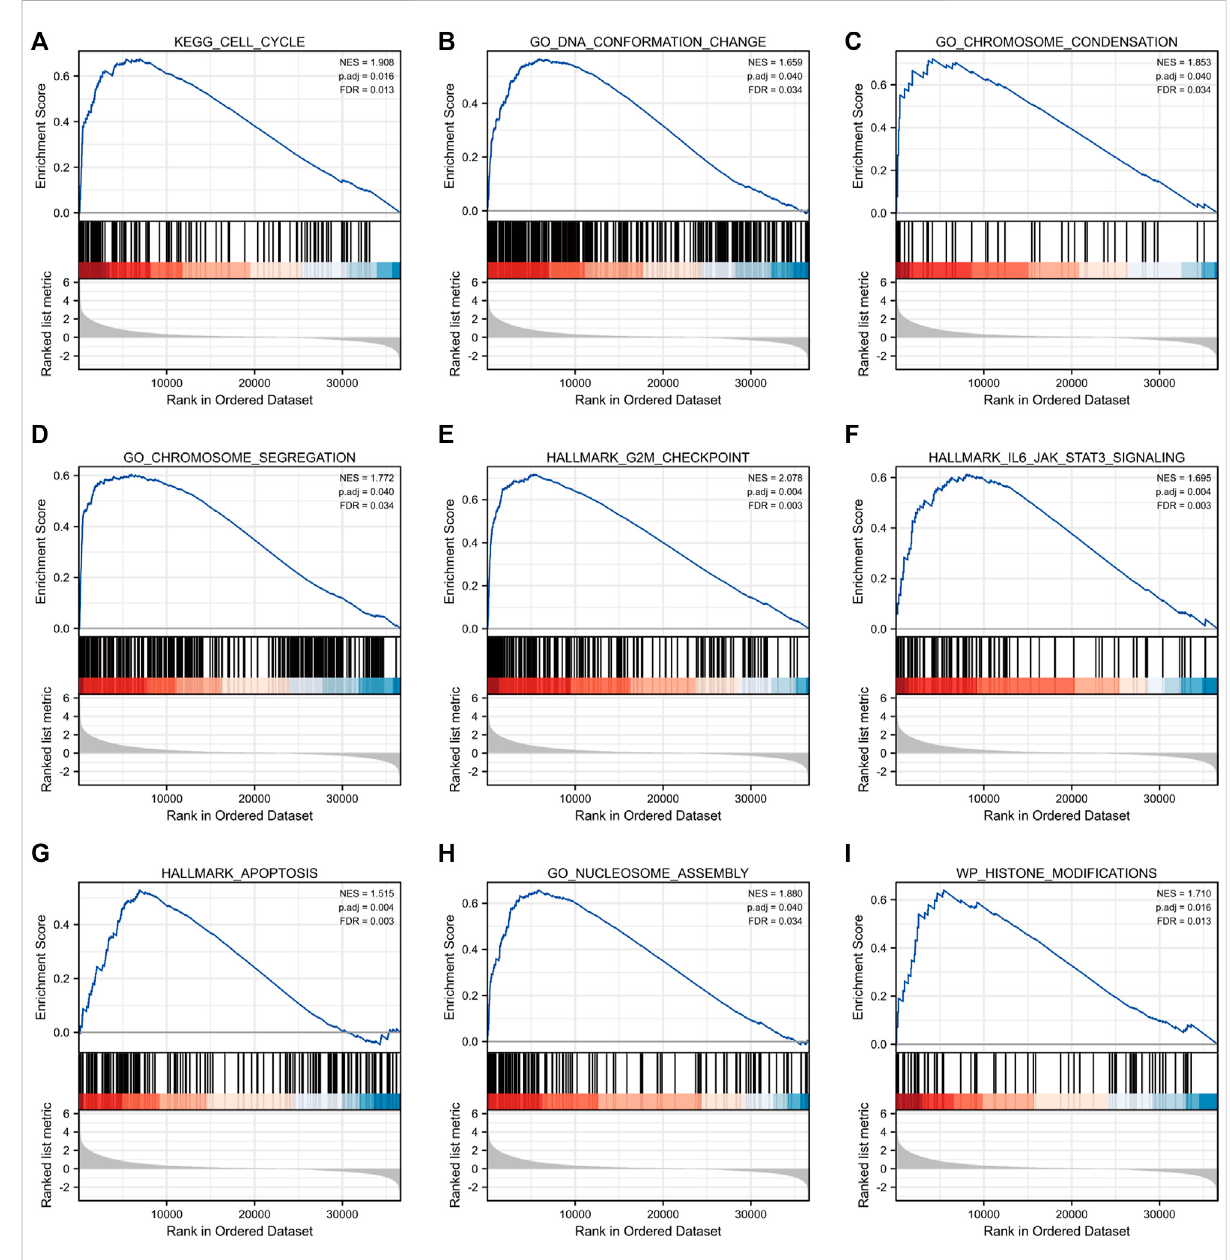
FIGURE 7 Gene set enrichment analysis (GSEA) enrichment plots including (A) cell cycle, (B) DNA conformation change, (C) chromosome condensation, (D) chromosome segregation, (E) G2M checkpoint, (F) IL6-JAK-STAT3 signaling, (G) apoptosis, (H) nucleosome assembly and (I) histone modi fi